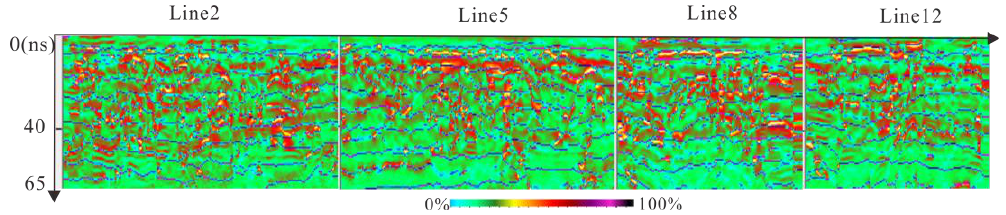
Figure 12. Relative water content calculation for the set of lines 2, 5, 8 and 12.